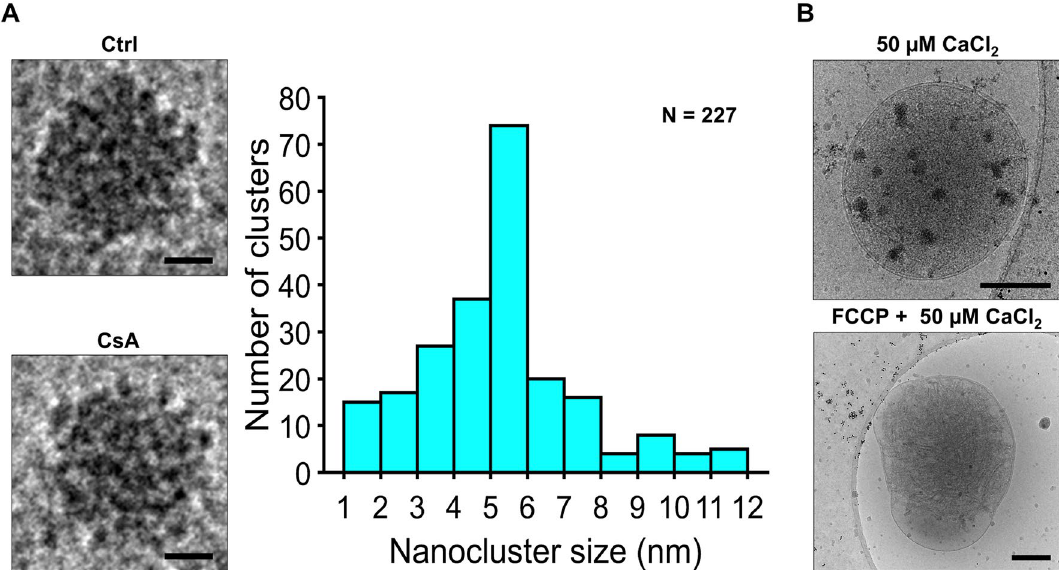
Figure 7. Calcium phosphate granule structure and the effect of membrane potential dissipation. ( A ) To the right, representative images of calcium phosphate granules for each calcium condition in the presence or absence of CsA shows near identical structure. To the left, each granule consists of many individual electron- dense calcium phosphate nanoclusters with a diameter of 5.3 ± 2.1 nm. Scale bars for the granules are 25 nm. ( B ) Representative image of a mitochondrion after the addition of a 50 µM CaCl 2 bolus contained several visible granules. The uncoupled mitochondrion with 1 µM FCCP before the addition of a 50 µM CaCl 2 bolus did not contain granules. For the latter, over 100 mitochondria were surveyed, and none contained any granules. The dark spots outside and around the mitochondrion are contaminating ice and gold fiducials approximately 10 nm in diameter. Scale bars are 250 nm.